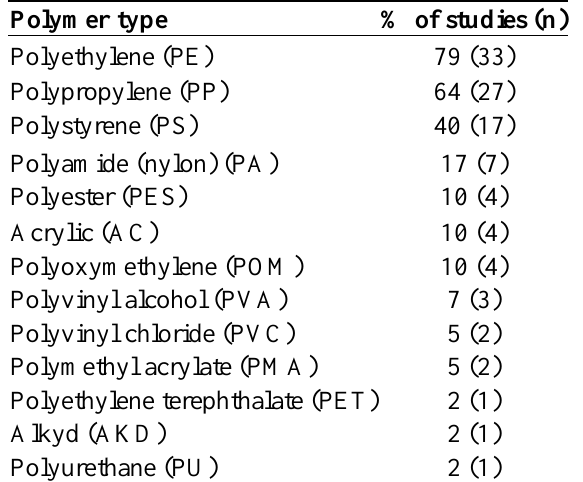
Table 1. According to the results of 42 studies, the most common types of MPs in the aquatic environment